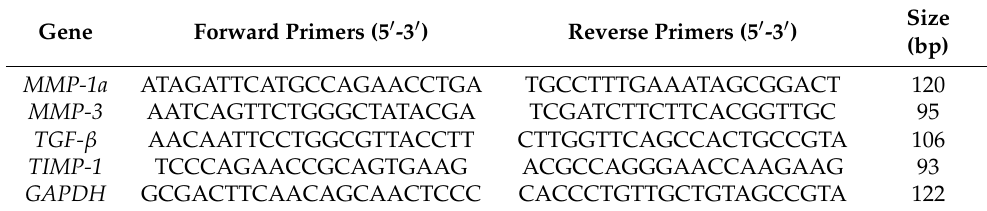
Table 1. Sequences of primers used for